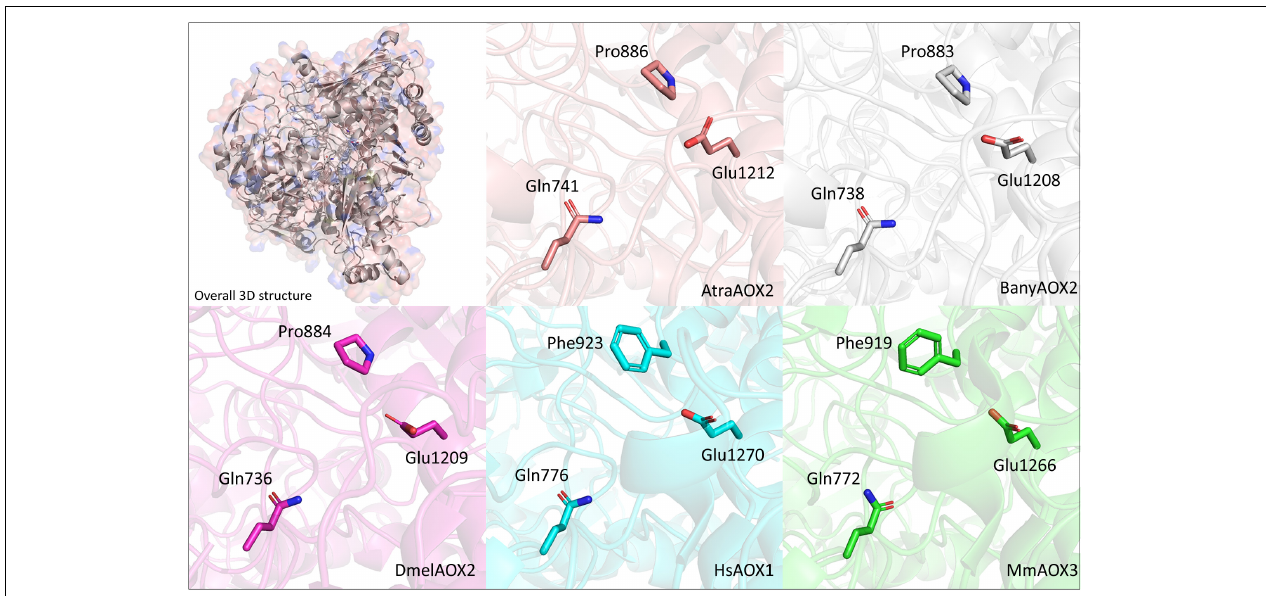
FIGURE 4 | Visualization of the location of conserved residues in 3D representations of the active site of A. transitella AOX2 (AtraAOX2—orange), B. anynana AOX2 (BanyAOX2—gray), D. melanogaster AOX2 (DmelAOX2—pink), H. sapiens AOX1 (HsAOX1—cyan) and M. musculus AOX3 (MmAOX3—green). Residues and their positions are indicated in each AOX. Mammal AOXs were retrieved from Protein Data Bank (https://www.rcsb.org/) and DmelAOX2 was downloaded from AlphaFold database